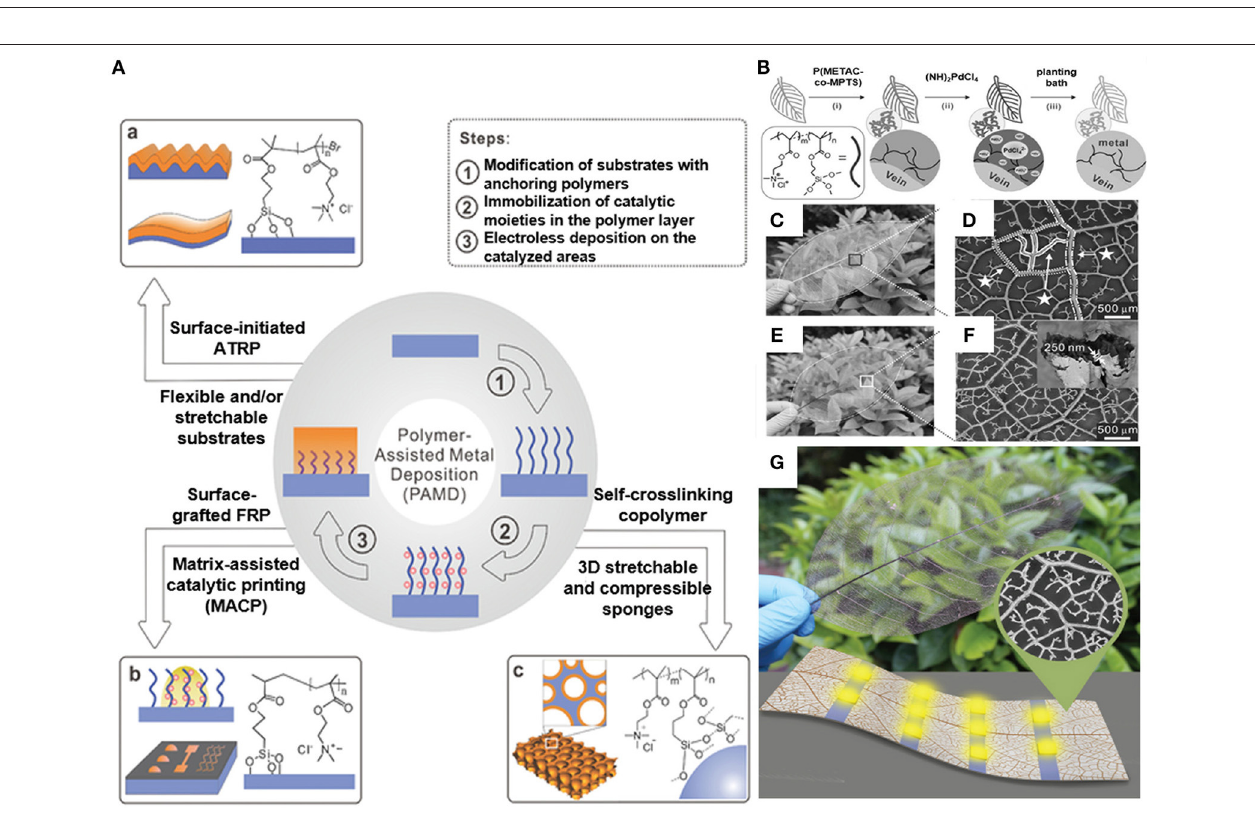
FIGURE 10 | (A) Schematic illustration of polymer-assisted metal deposition and its various applications, including patterned metal electrodes and metal sponges (Yu et al., 2014). Reproduced with the permission of 2014 WILEY-VCH Verlag GmbH & Co. KGaA, Weinheim. (B) Fabrication process of vein-based transparent electrodes. (C,D) SEM images of natural veins. (E,F) SEM images of vein-based transparent electrodes. (G) Optical photography of vein-based electrodes (Yu et al., 2015a). Reproduced with the permission of 1999–2018 John Wiley & Sons, Inc.